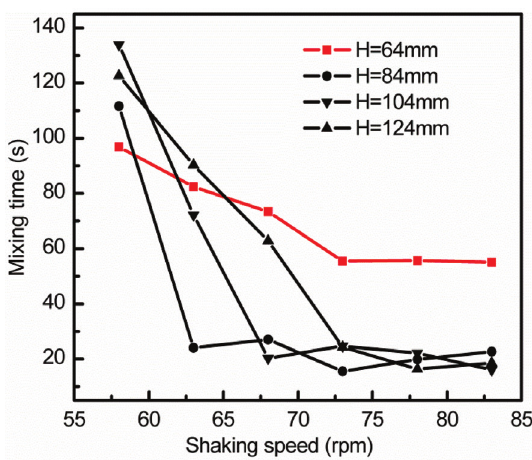
Fig. 7: Measured mixing time as a function of shaking speed with different bath depths at a = 30